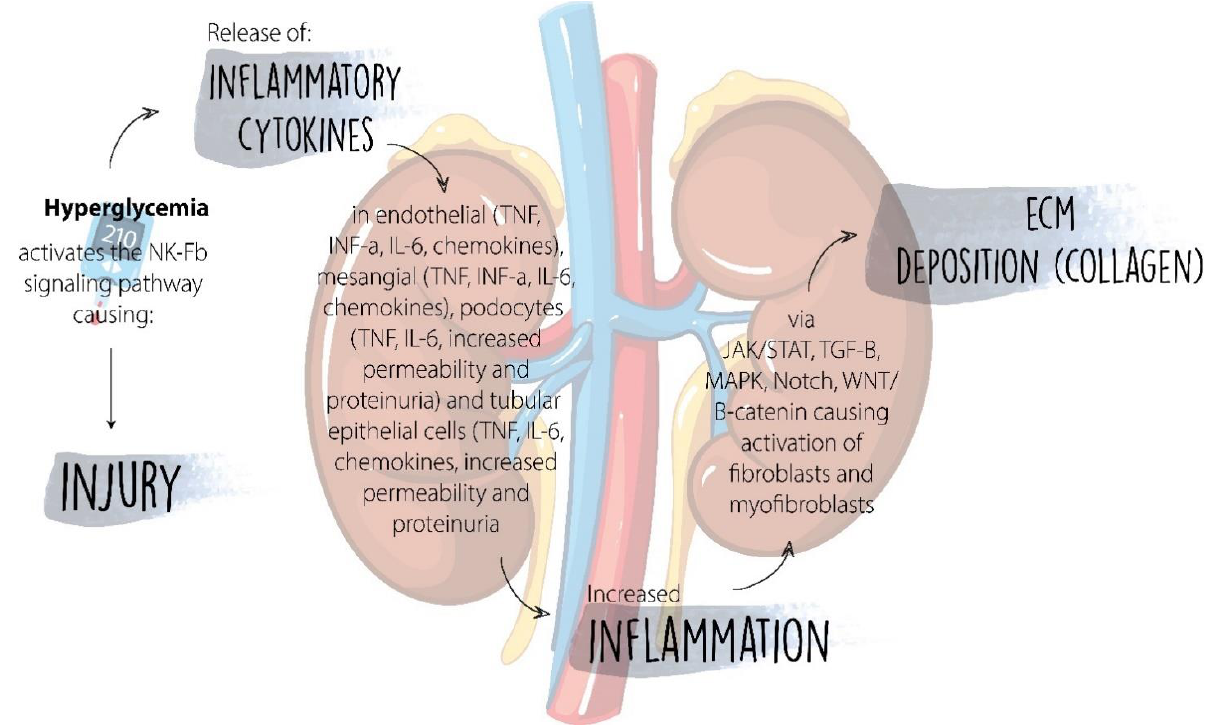
Figure 2. Hyperglycemia leads to the production of pro-inflammatory cytokines and chemokines in several cell types in the kidney including endothelial cells, mesangial cells, podocytes and tubular epithelial cells, causing inflammation via signaling pathways such as the JAK/STAT, TGF- β, Notch among others, leading to fibrosis.